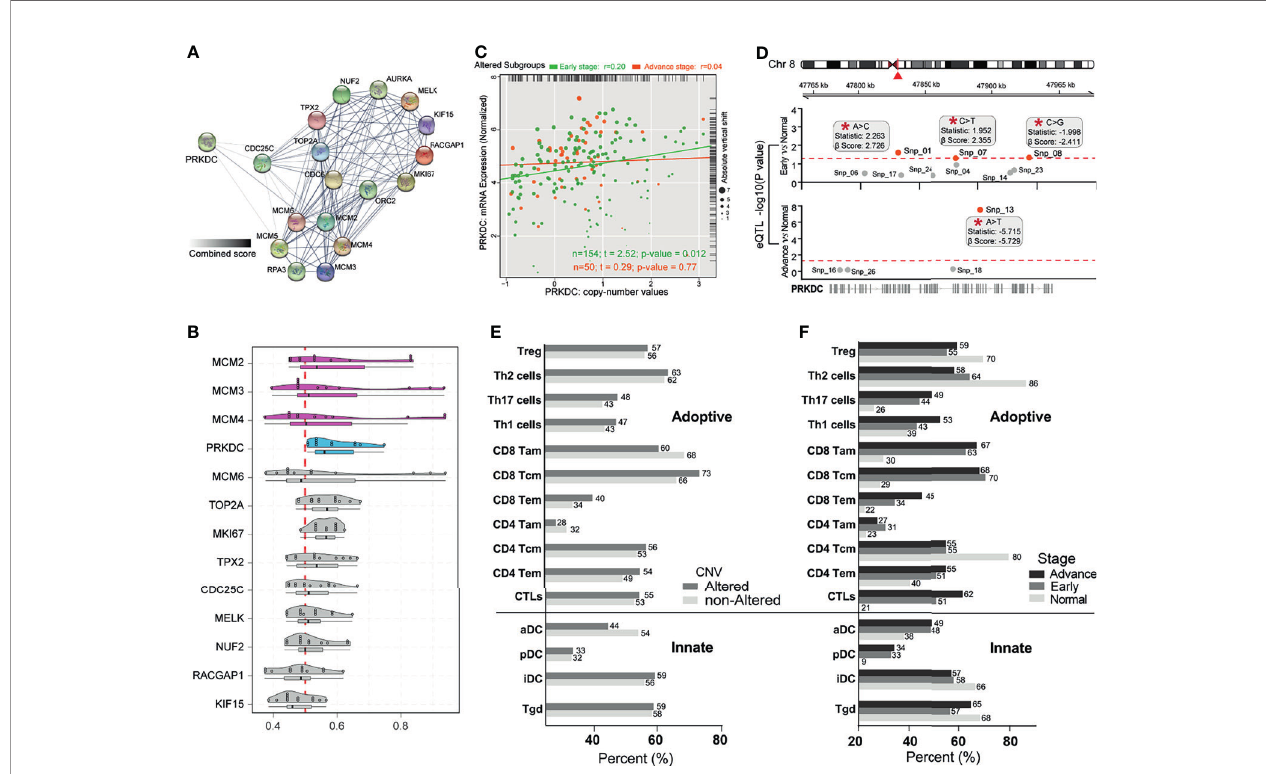
FIGURE 5 | Identi fi cation of PRKDC dysregulation in eHCC and immune-related poor prognostic signatures. (A) The PPI network analysis of Cluster C1-related differentially expressed proteins. Thicker lines and deeper color represent the closer association between each other. (B) Summary of functional similarities of Cluster C1 genes. The distributions of functional similarities and ranked central proteins are summarized as boxplots; lines in the boxes indicate the mean of average value. (C) Scatter plots depicting the positive correlation between PRKDC expression and copy number variation in patients with eHCC and aHCC. Pearson ’ s correlation coef fi cient is shown in the graphs. (D) Cis-eQTLs for PRKDC in two subgroups of HCC patients. Signi fi cant novel SNPs are indicated by the red mark and labels (*). The statistics used is correlation coef fi cient “ r ” ; and b -Score is the con fi dence index. The red line corresponds with a threshold of p ≤ 0.05. (E) Immune cell-related poor prognostic signature pro fi les. Comparison of immune cell-related poor prognostic signature pro fi les in HCC patients with altered PRKDC (n = 204) versus non- altered PRKDC (n = 161). Alteration including somatic mutation and copy number ampli fi cation, gain, and shallow deletion. Gray bars indicate the percentage of patients having immune cell-related poor prognostic signature in altered-PRKDC HCC group, while the gray bars represent the percentage in non-altered PRKDC group. (F) Comparison of immune cell-related poor prognostic signature pro fi les in three pathological stage patients: eHCC (n = 91), aHCC (n = 274), and non-tumor (n = 161). Black bars represent the percentage of aHCC patients, gray bars represent the percentage of eHCC patients, and gray bars represent the percentage of non-tumor samples. Immune cell signatures were classi fi ed to adaptive and innate. eHCC, early-stage hepatocellular carcinoma; PPI, protein – protein interaction; aHCC, advanced-stage hepatocellular carcinoma; eQTL, expression quantitative trait locus; SNP, single-nucleotide